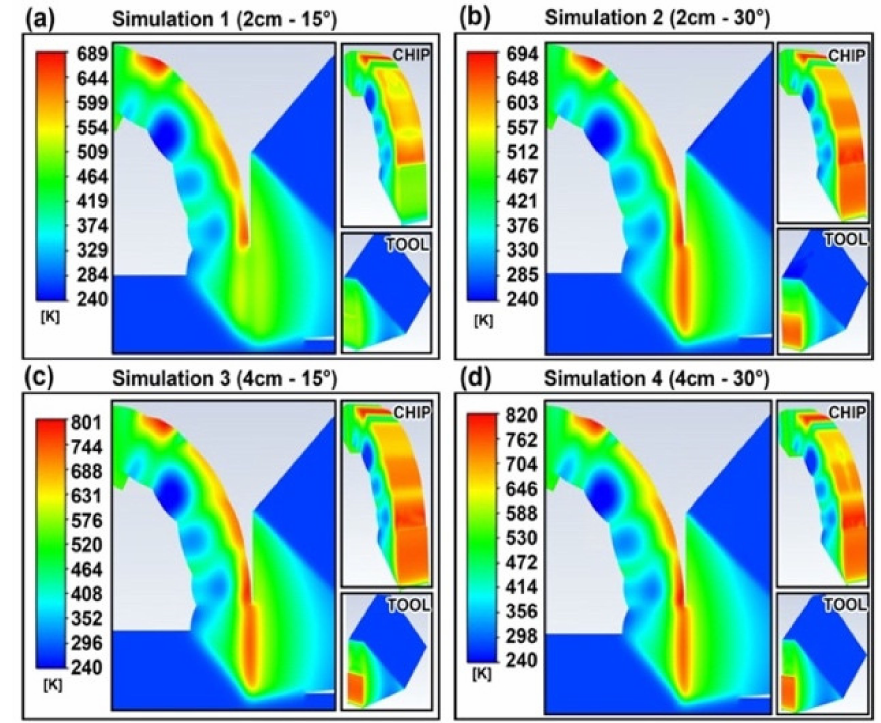
Figure 5. Temperature Profiles (in